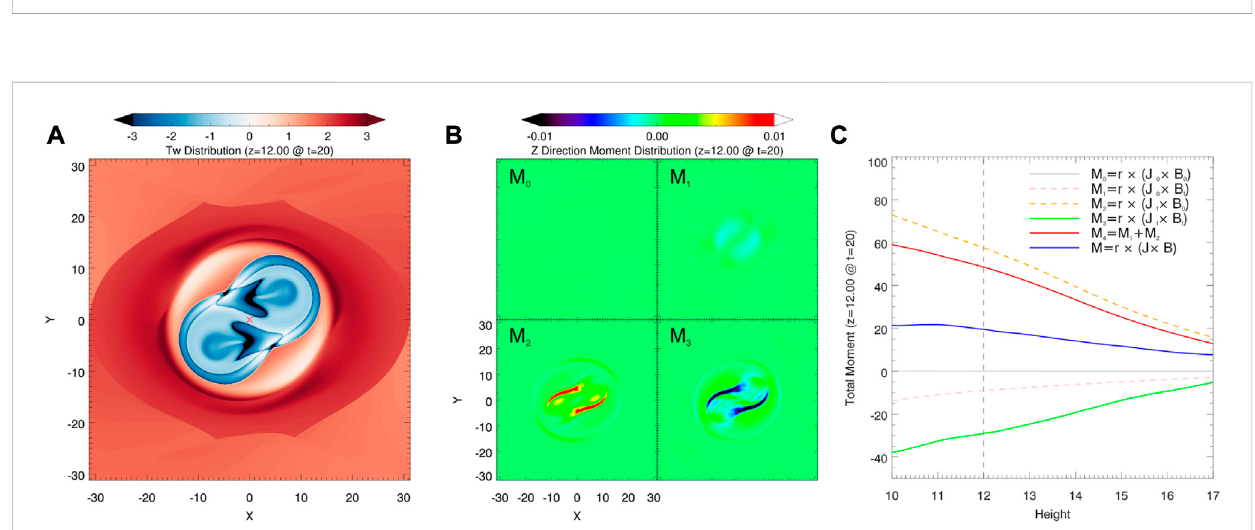
FIGURE 3 Torque analysis at t =20 t s . (A) Distribution of twist number on the horizontal slice at z = 12 l 0 . The red cross symbol is the center of rotation. (B) Distributions of each z -direction moment component on the z-constant plane (z = 12 l 0 ). (C) The z -direction component of Lorentz torque induced by the external fi eld ( M 0 , grey line), MFR itself ( M 3 , green line), their interaction force ( M 4 , red line), and the total force ( M , blue line) integrated on each horizontal slice. The black vertical dashed lines show the location of the left